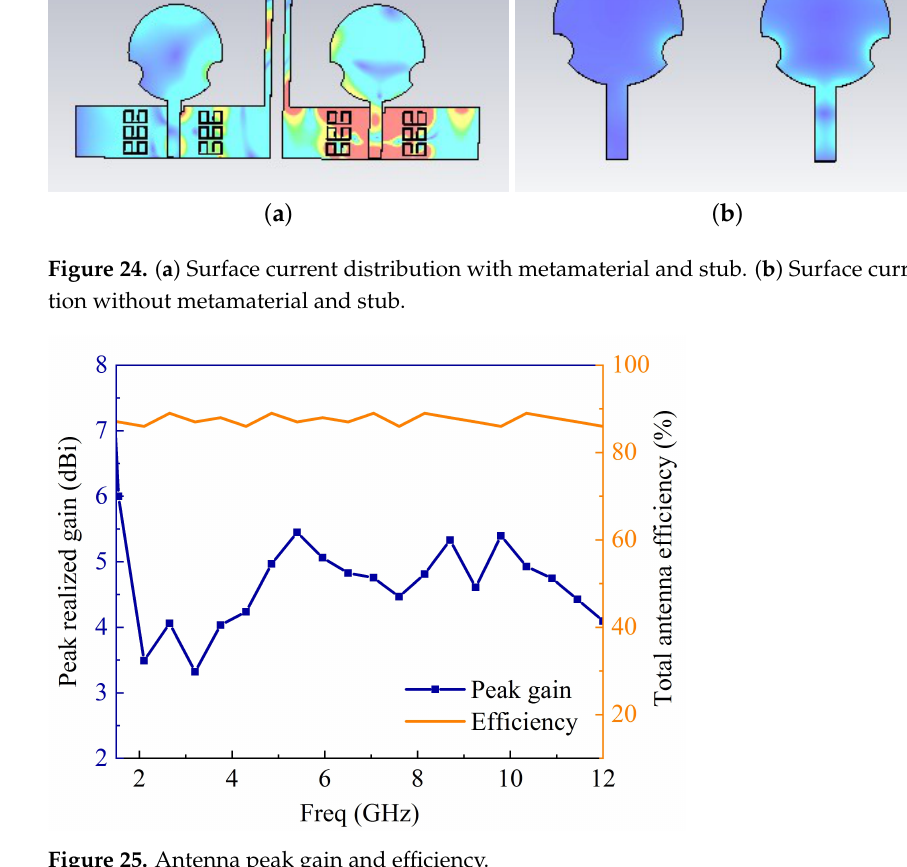
Figure 25. Antenna peak gain and efficiency.